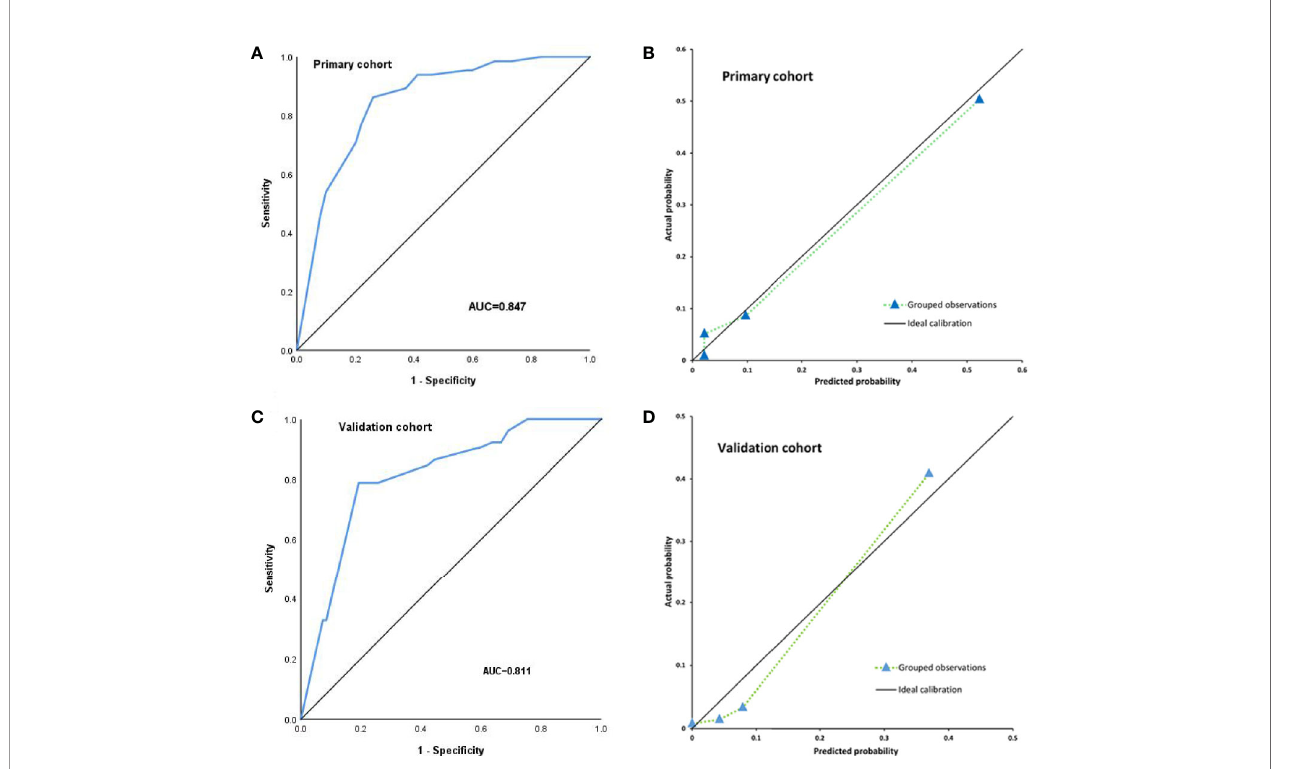
FIGURE 3 | Internal validation for TLI risk in the primary cohort by nomogram; the area under the receiver operating characteristic curve (AUC) was 0.847 (A) . The calibration curve for the prediction of TLI risk in the primary cohort (B) . External validation for TLI risk in the validation cohort by nomogram, the area under the receiver operating characteristic curve (AUC) was 0.811 (C) . The calibration curve for the prediction of TLI risk in the validation cohort (D)